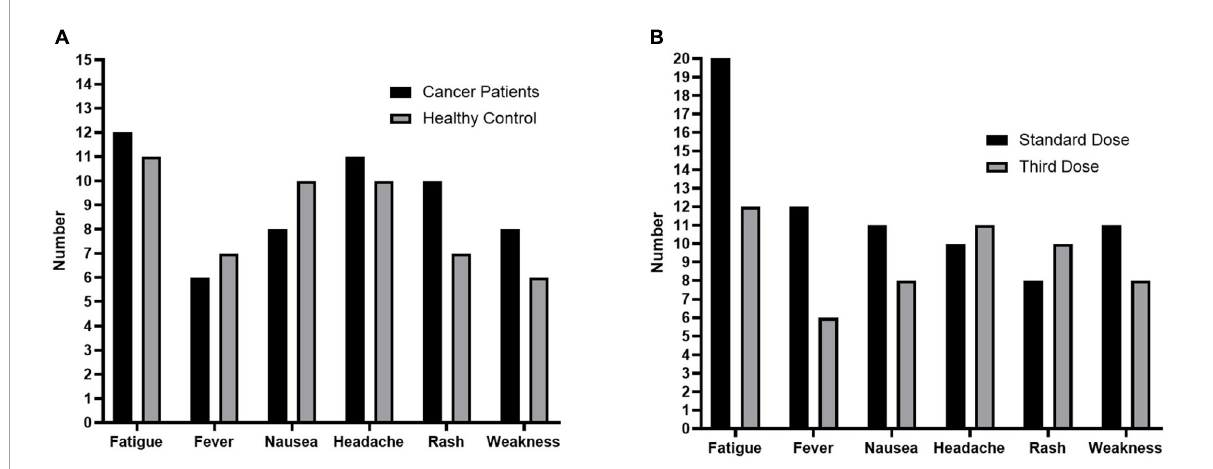
FIGURE3 Adverse Events in the study. (A) , Adverse events after the third dose in solid cancer patients who were seronegative after standard-dose vaccination (SCP-N, n = 97) and healthy control participants (HC, n = 82). (B) , Adverse events after the third dose and standard dose of COVID-19 vaccination in